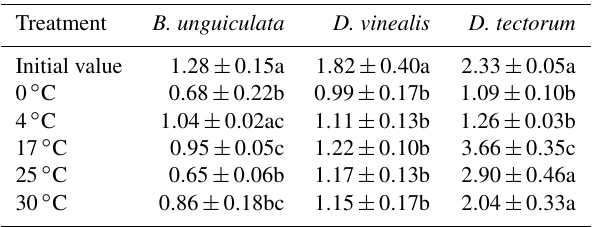
Table 2. Gametophyte vigor index of the three mosses under treat-